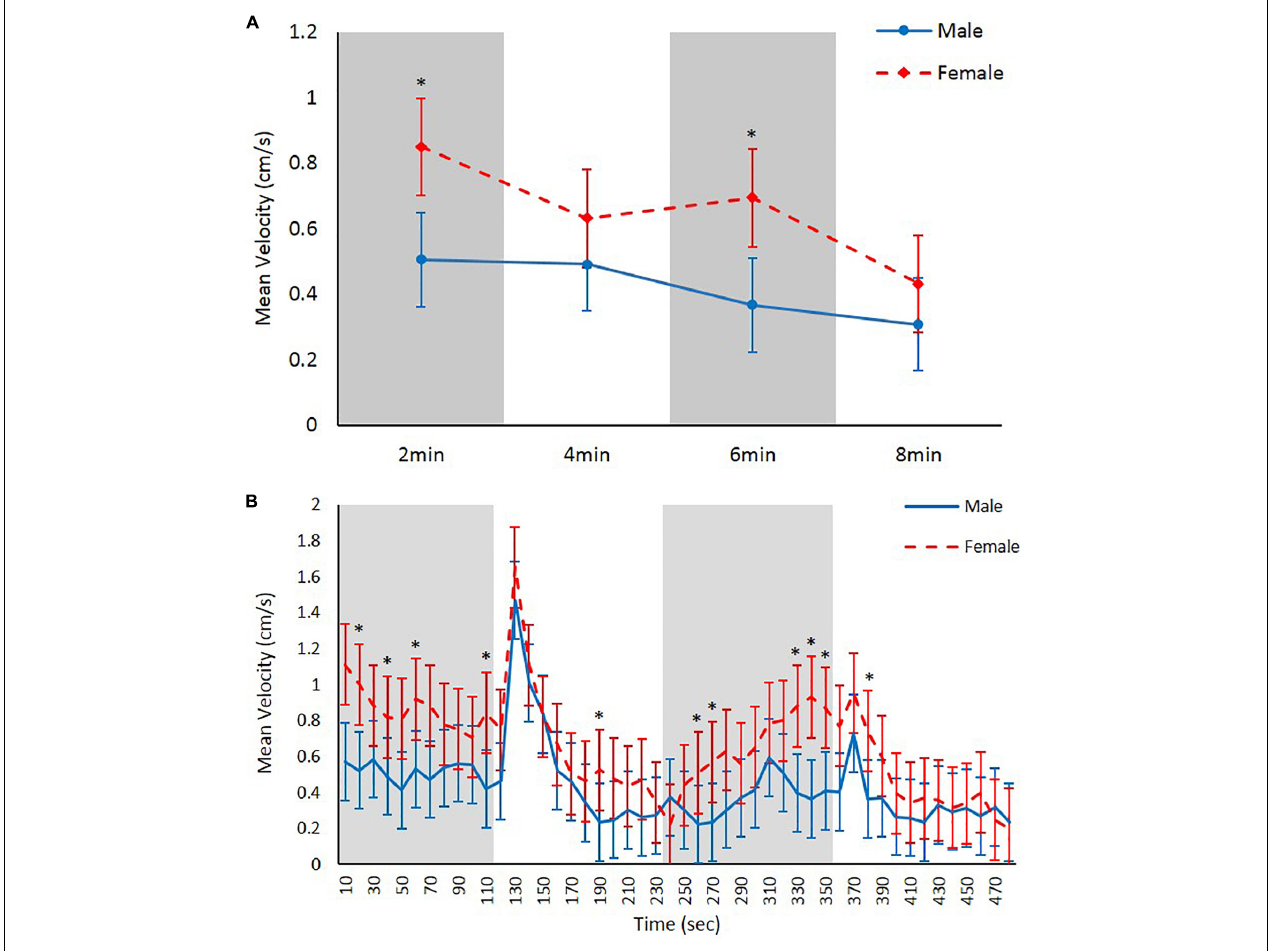
FIGURE 2 | Mean swimming velocity (cm/s) in male and female Echinogammarus marinus recording over (A) 2 min time and (B) 10 s time bins. Error bars represent 2 × SE. * ≤ 0.00075.